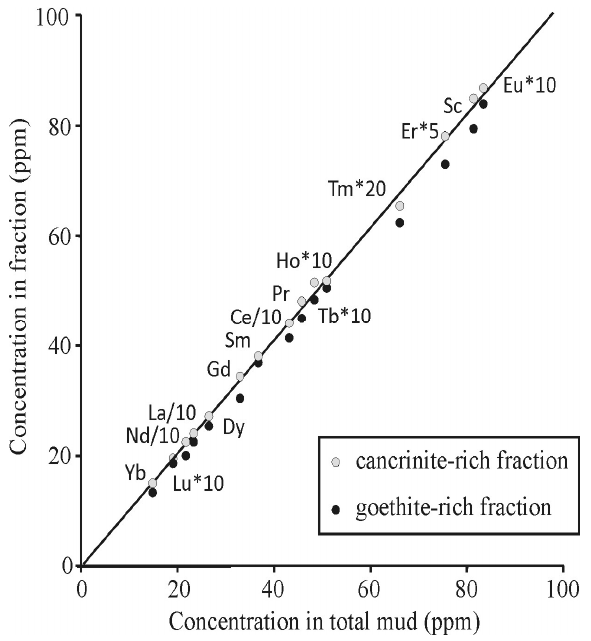
Figure 6. REE concentrations in the goethite-rich and the cancrinite-rich fractions relative to the original red mud sample.